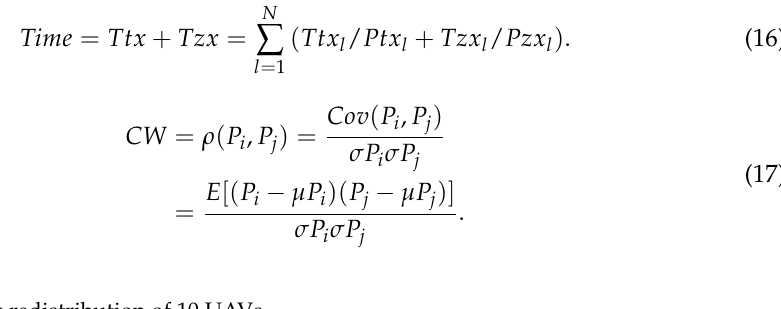
Table 6. Virtual task redistribution of 10